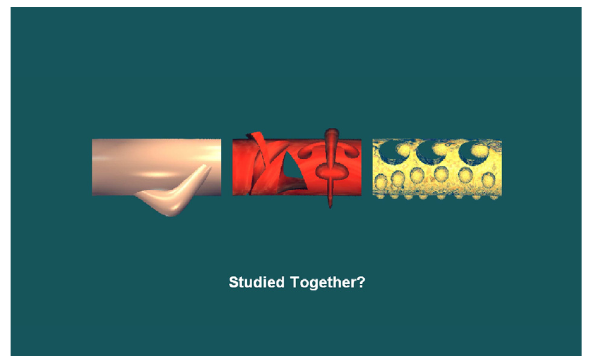
Figure 4 | A sample manipulated associative relations test trial based on Figure